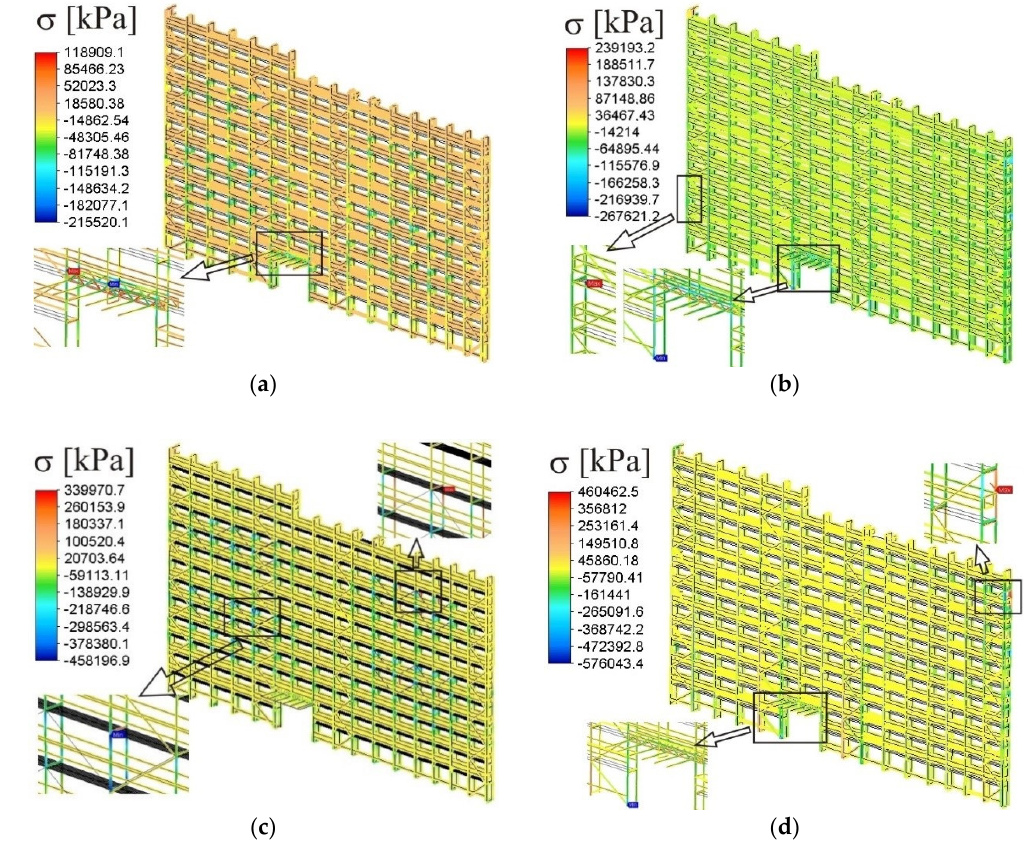
Figure 6. Normal stress in L12 scaffolding for the C1 configuration, caused by self-weight and: service load and wind perpendicular to the facade according to [32] ( a ); service load and wind parallel to the facade according to [32] ( b ); perpendicular wind according to [33] ( c ); parallel wind according to [33] ( d ).